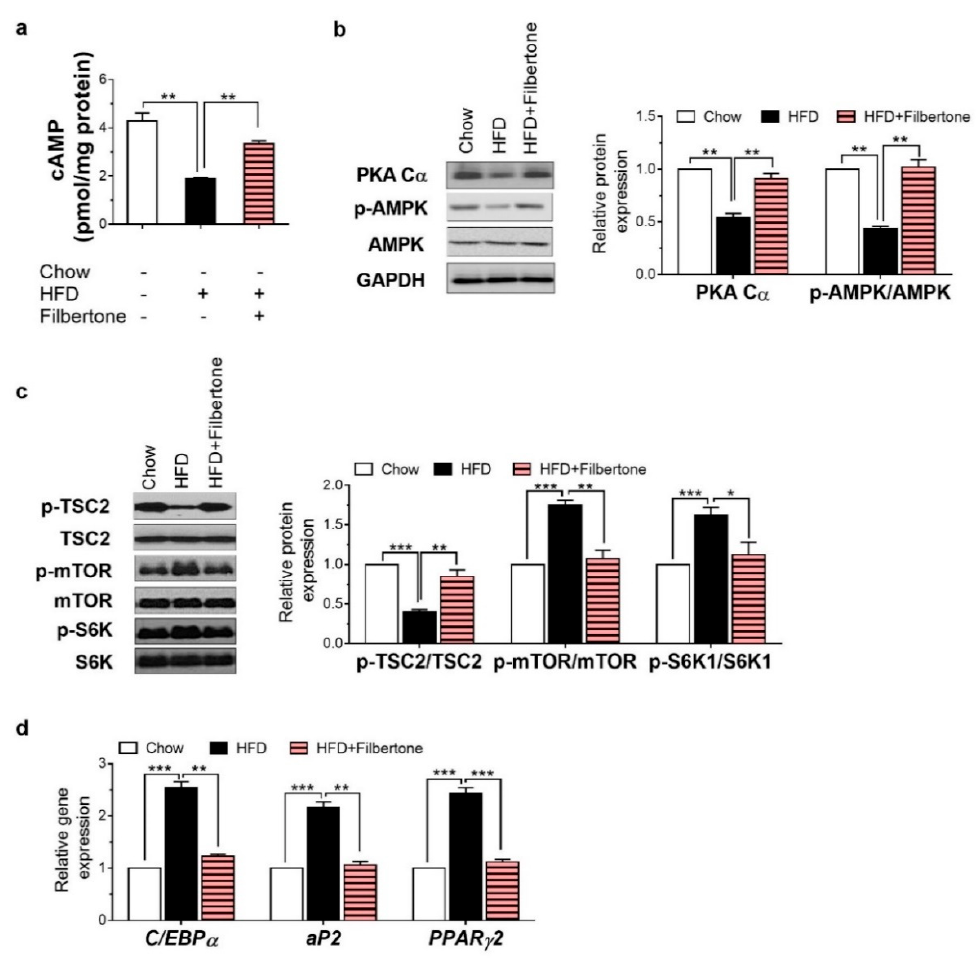
Figure 3. Filbertone regulates the expression of adipogenesis-related factors in mouse adipose tissue. ( a ) Cyclic adenosine monophosphate (cAMP) concentrations in mouse epididymal adipose tissue. ( b ) Protein levels of protein kinase A catalytic subunit (PKA C α ), phosphorylated adenosine monophosphate activated protein kinase (p-AMPK), and adenosine monophosphate activated protein kinase (AMPK) in mouse adipose tissue. ( c ) Protein levels of phosphorylated tuberous sclerosis complex 2 (p-TSC2), tuberous sclerosis complex 2 (TSC2), phosphorylated mechanistic target of rapamycin (p-mTOR), mechanistic target of rapamycin (mTOR), phosphorylated ribosomal protein S6 kinase 1 (p-S6K1), and ribosomal protein S6 kinase 1 (S6K1) in mouse adipose tissue. ( d ) Real time RT-PCR analysis of C/EBP α , aP2 , and PPar γ 2 in mouse adipose tissue. * p < 0.05, ** p < 0.01, and *** p < 0.001, between the groups. Values are means ± SEM.